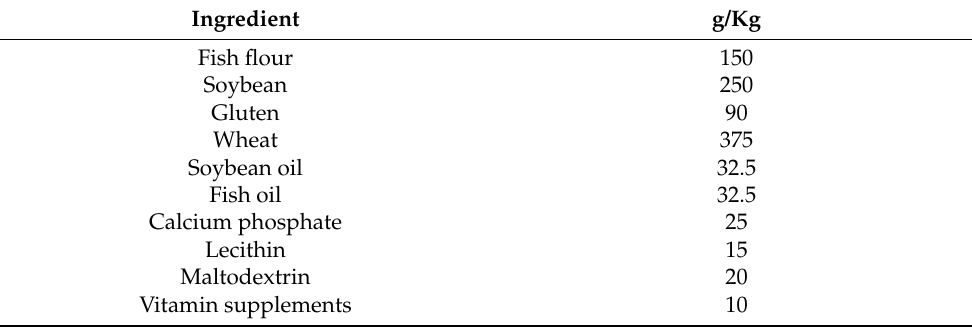
Table 1. Ingredient content and proximate basal composition of experimental